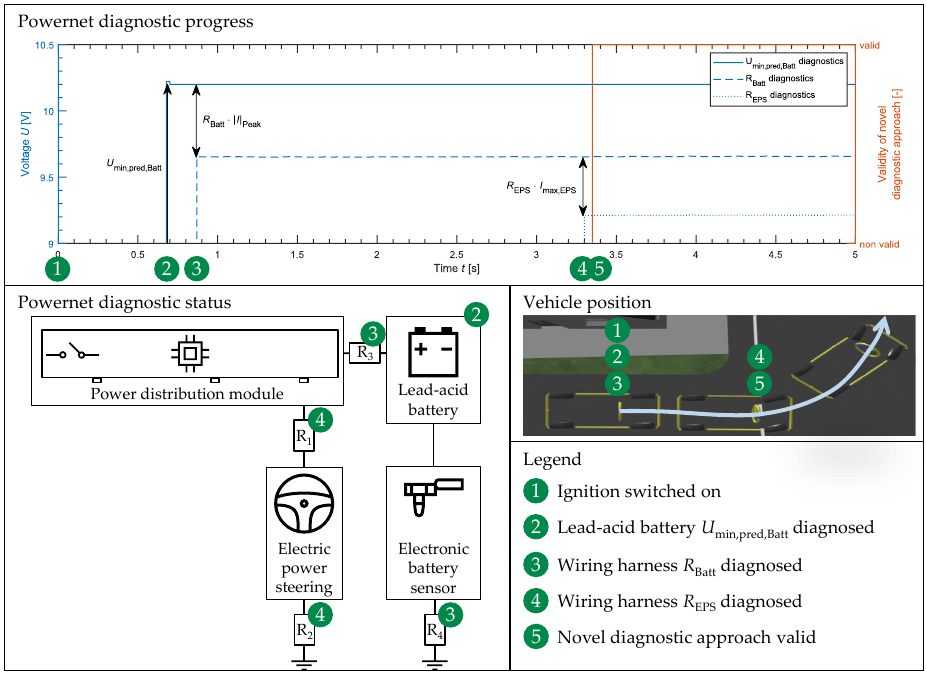
Figure 8. Determination of the state of powernet by using the SOFPN at the start of the drive cycle. Visualization of chronological progression and status of the diagnostics with the respective vehicle